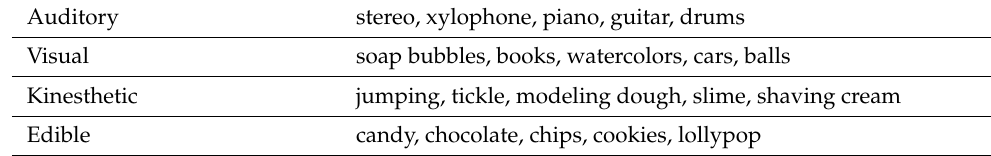
Table 2. PECS images.